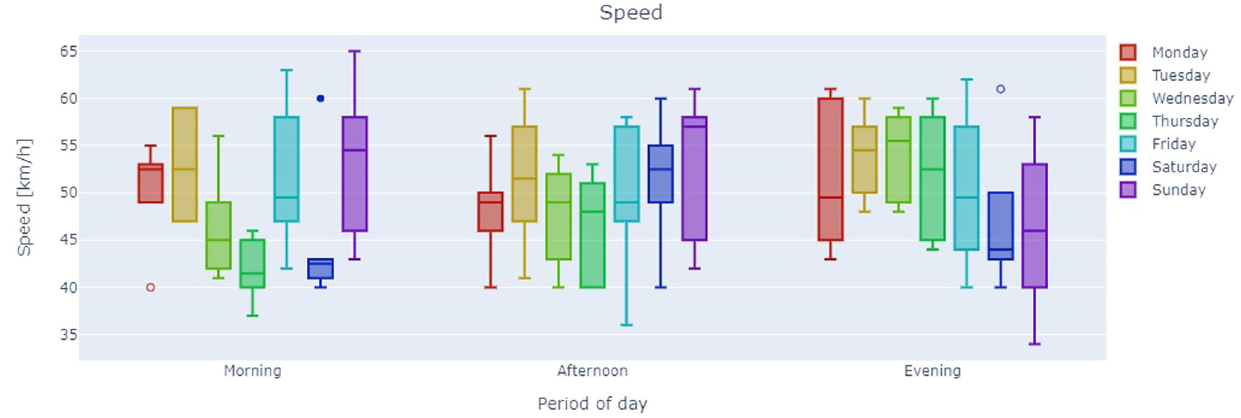
Fig. 8 Speed measurements distributions